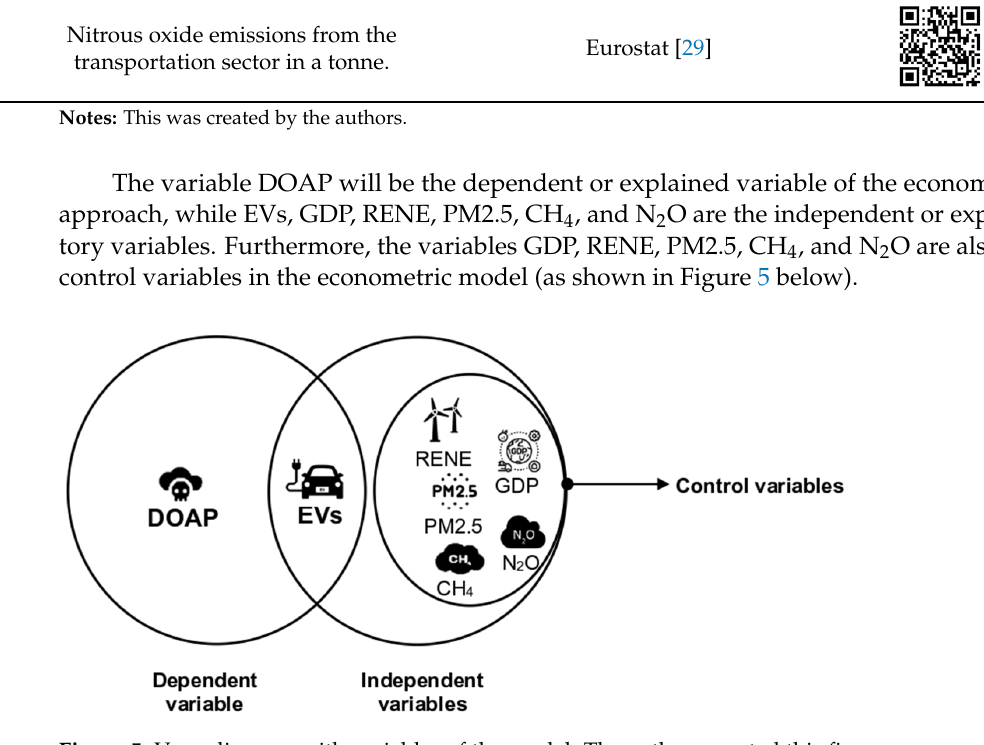
Figure 5. Venn diagram with variables of the model. The authors created this figure.